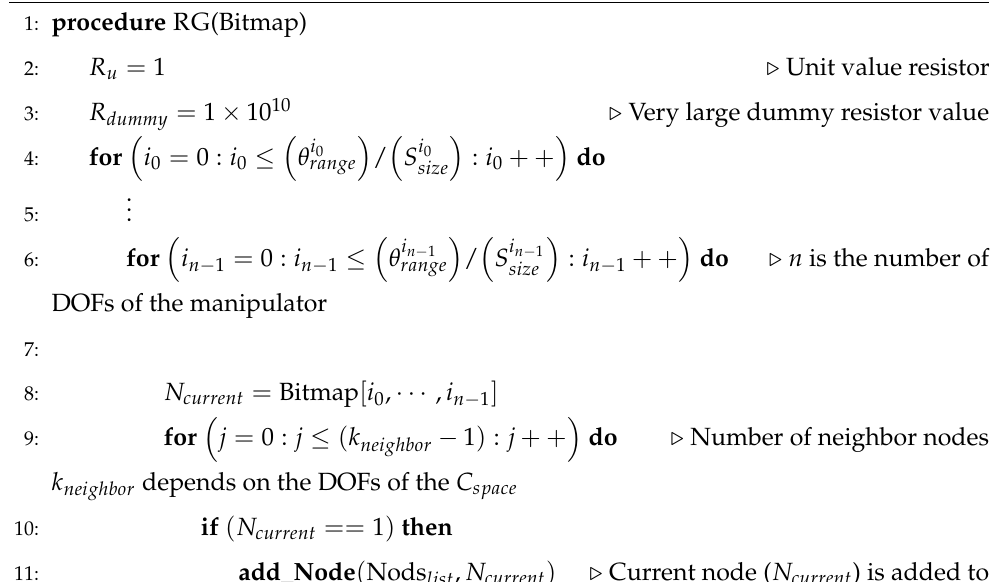
Algorithm 2 Resistive grid and MNA matrix